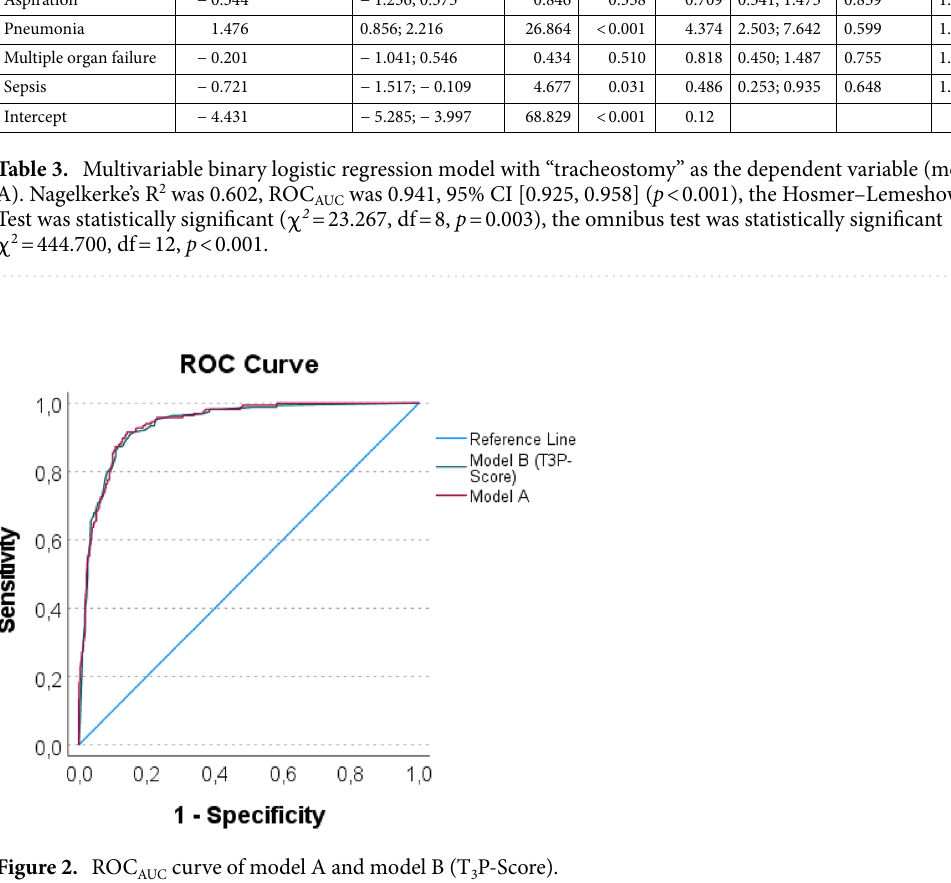
Figure 2. ROC AUC curve of model A and model B (T 3